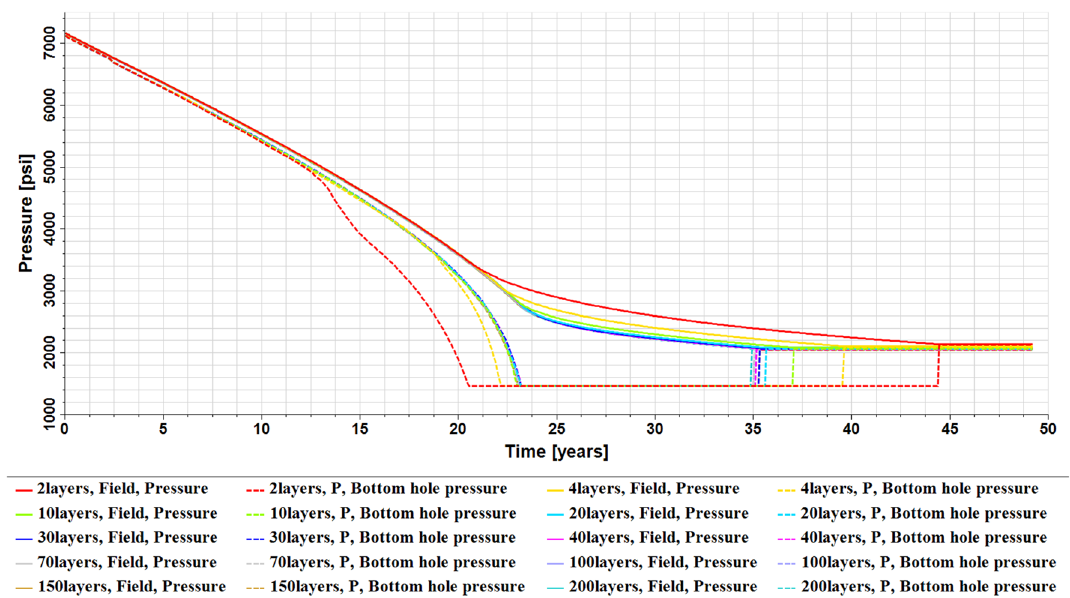
Fig. 8 Reservoir pressure and bottom-hole flowing pressure for models with different layers